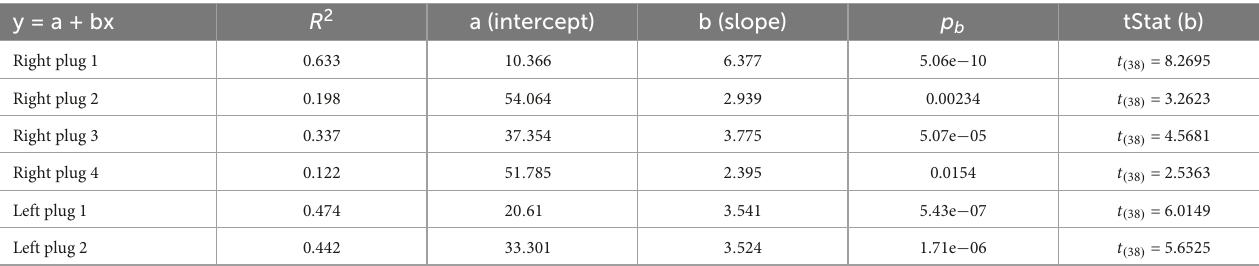
TABLE 2 Parameters of the fitted regression lines during earplug